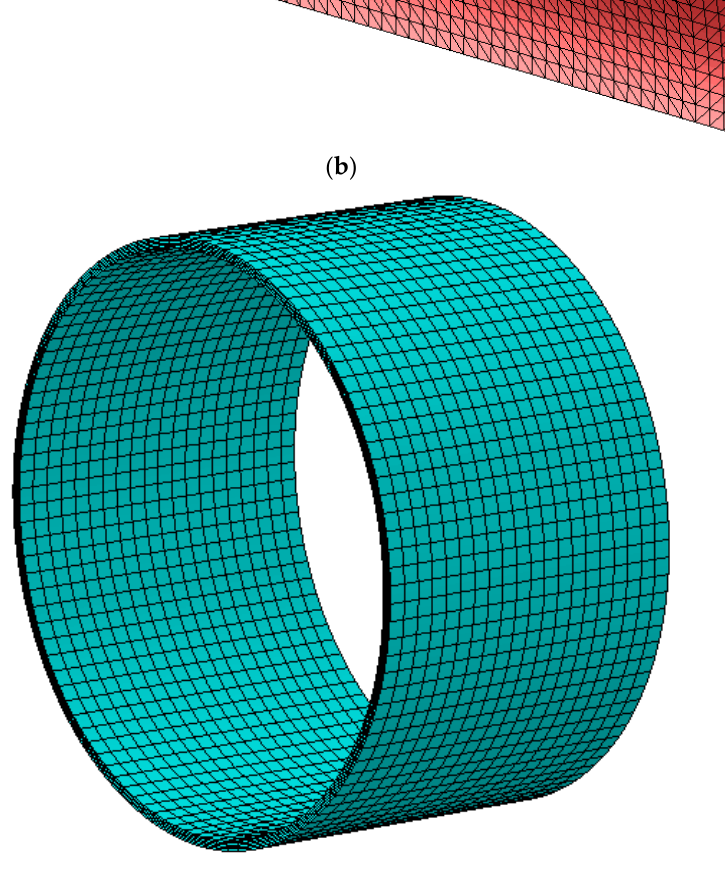
Figure 7. Meshes generated for the different models: ( a ) global model, ( b ) SM1, ( c ) SM2. Table 4. The number and type of elements used in each model.